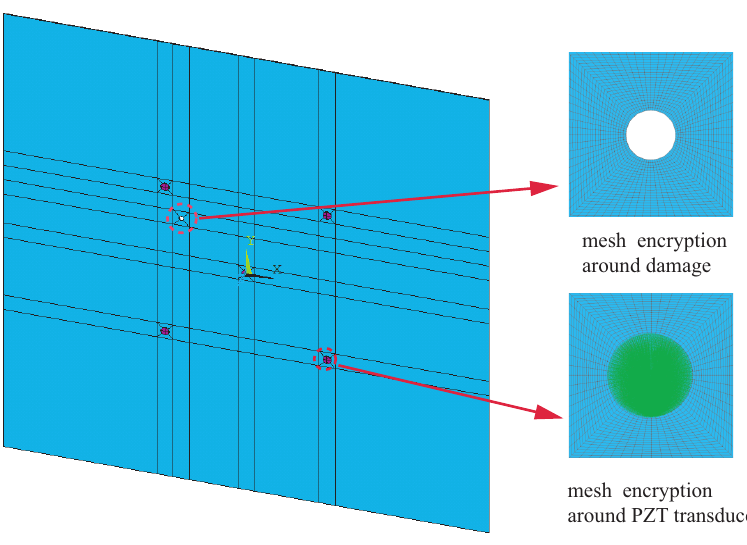
Figure 7. Details of numerical model.